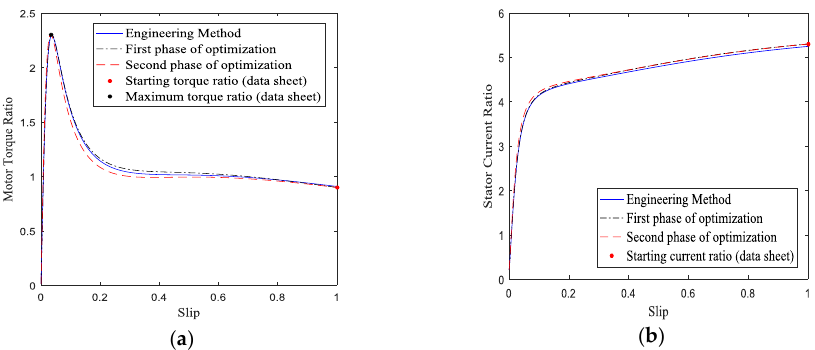
Figure 2. Characteristics of the induction motor number 10 (2A3M-2500/6000YXL4): ( a ) Torque-slip, ( b ) Current-slip. Table 4. Equivalent circuit model parameters determined by the engineering method and the two- stage optimization.